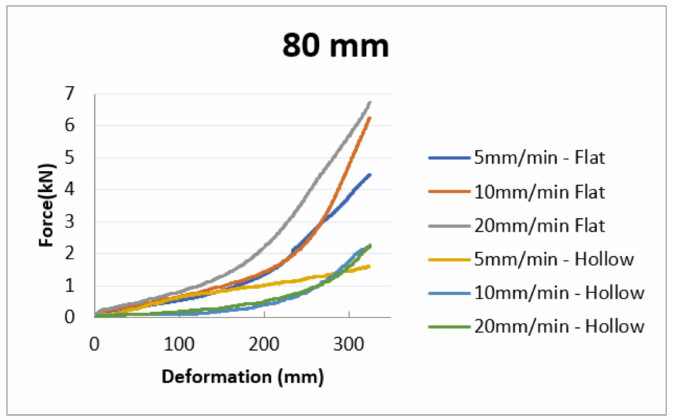
Figure 16. Deformation and force at each position for a diameter of 80 mm.